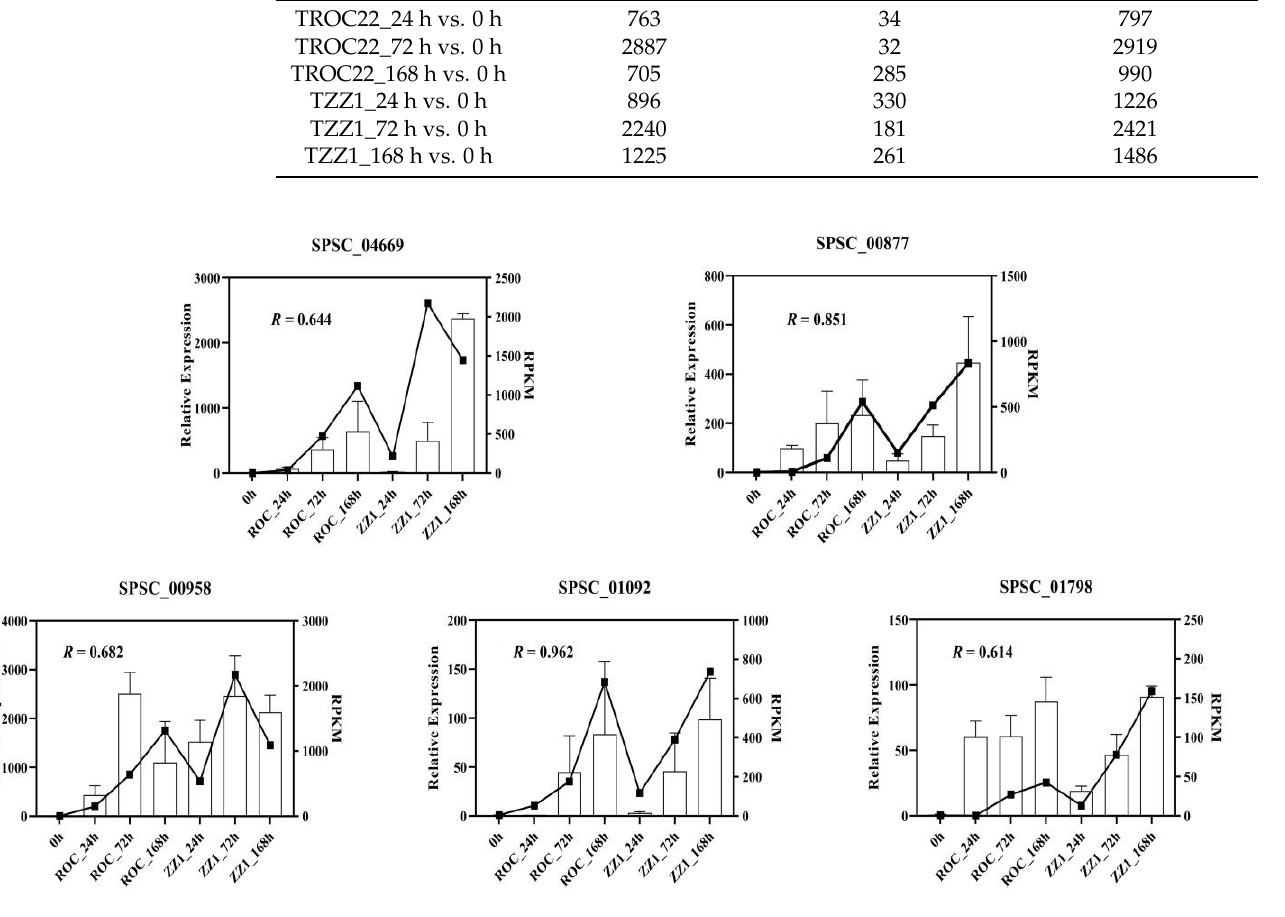
Figure 2. Validation of gene expression by RT-qPCR. Five randomly selected genes, SPSC_04669, SPSC_00877, SPSC_00958, SPSC_01092, and SPSC_01798, were selected for RT-qPCR analysis. Each treatment had three biological and three technical replicates. RNA-seq (left-axis) and RT-qPCR (right-axis) data representing the five genes are significantly correlated ( p < 0.05).